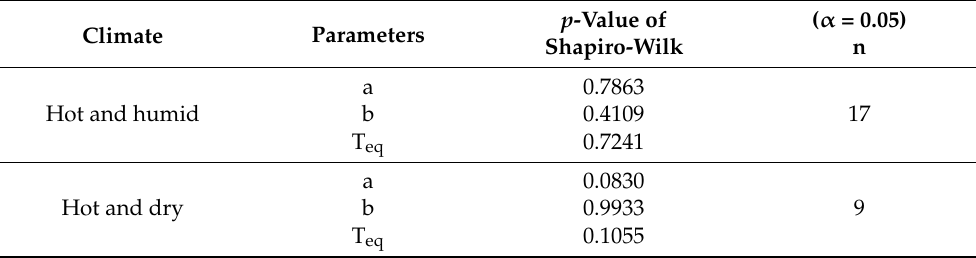
Table 3. Results of the Shapiro–Wilk test of normality applied to the parameters of the linear thermal comfort equations.